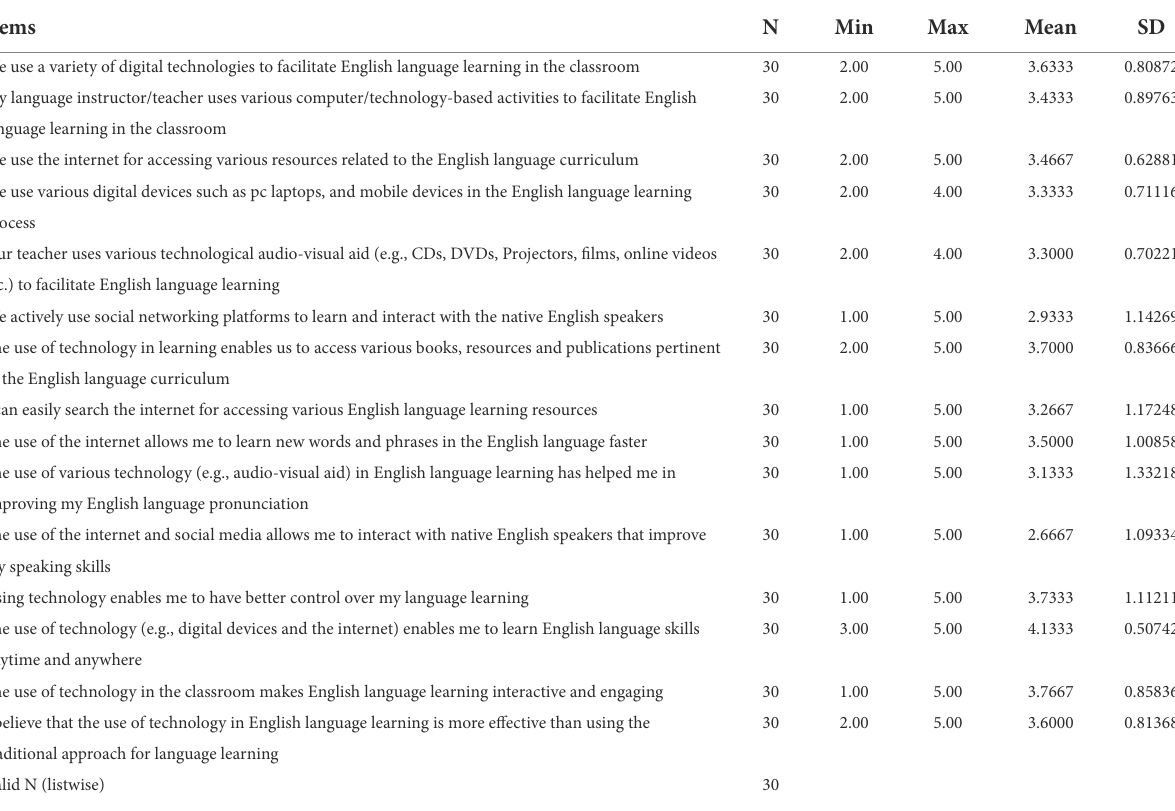
TABLE 3 Survey results of Indonesian linguistic students.